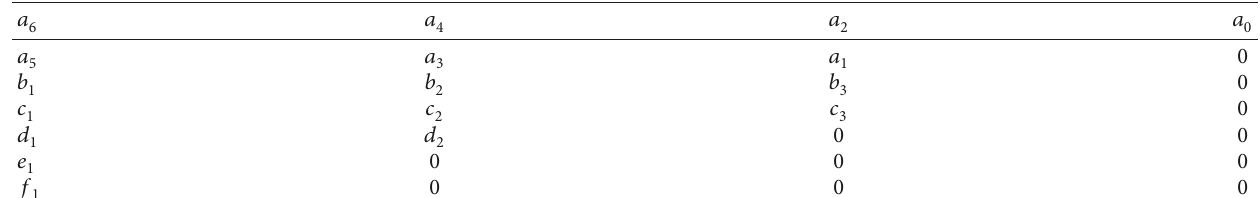
Table 1: Routh’s